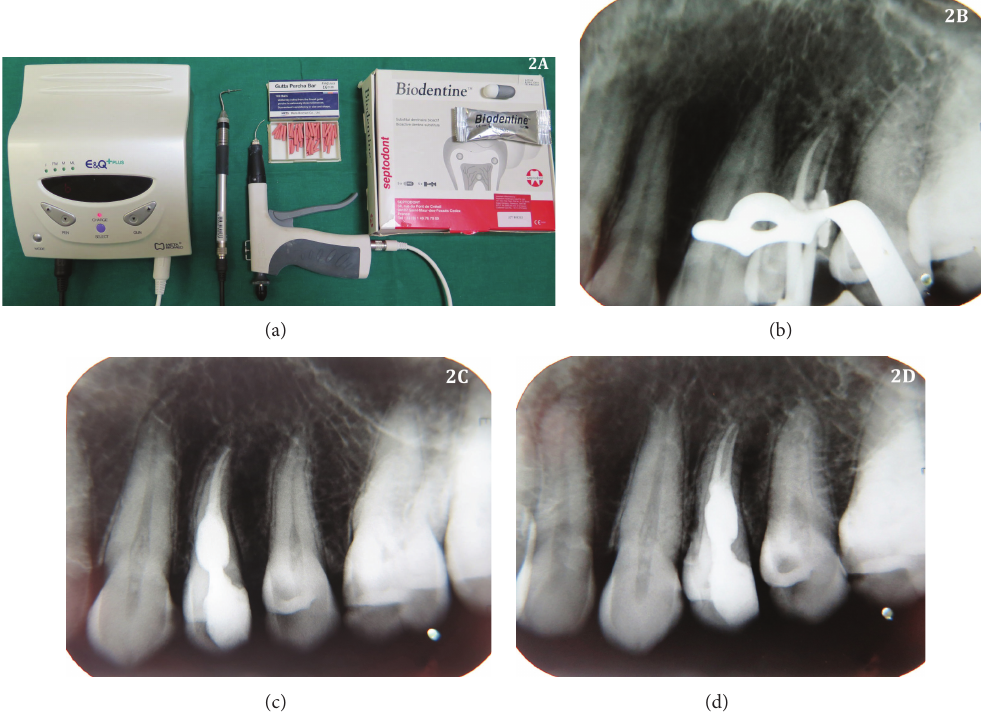
Figure 2: (a) E & Q (META BIOMED) system apparatus (pen, gun, and gutta-percha bar) and Biodentine capsule (Septodont, Saint-Maur- des-Foss´es, France). (b) Confirmatory radiograph after placement of Biodentine. (c) Immediate postoperative radiograph. (d) Ten-month follow-up